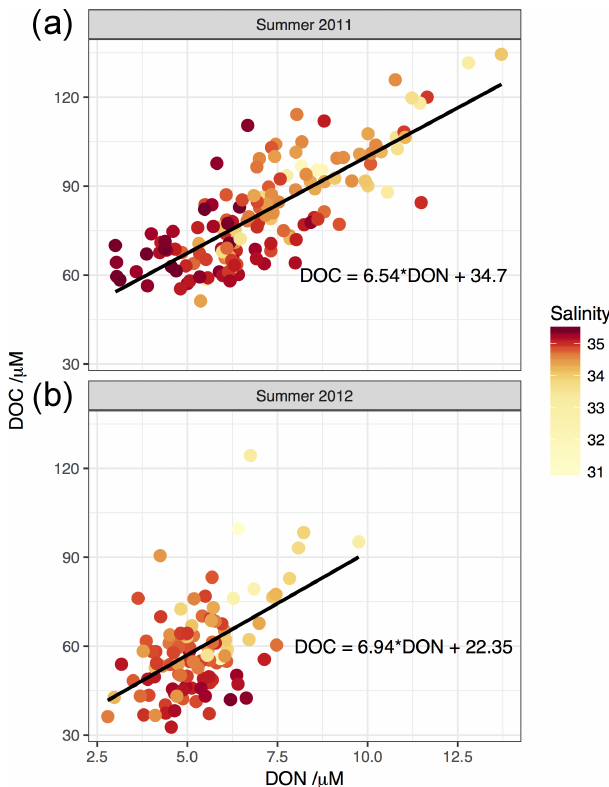
Figure 10. Element–element plots of DOC vs. DON for summer surveys (a) August 2011; (b) August 2012. Points are coloured by salinity. Lines represent application of standard linear least squares regression models to the relevant data; equations for which are quoted on the